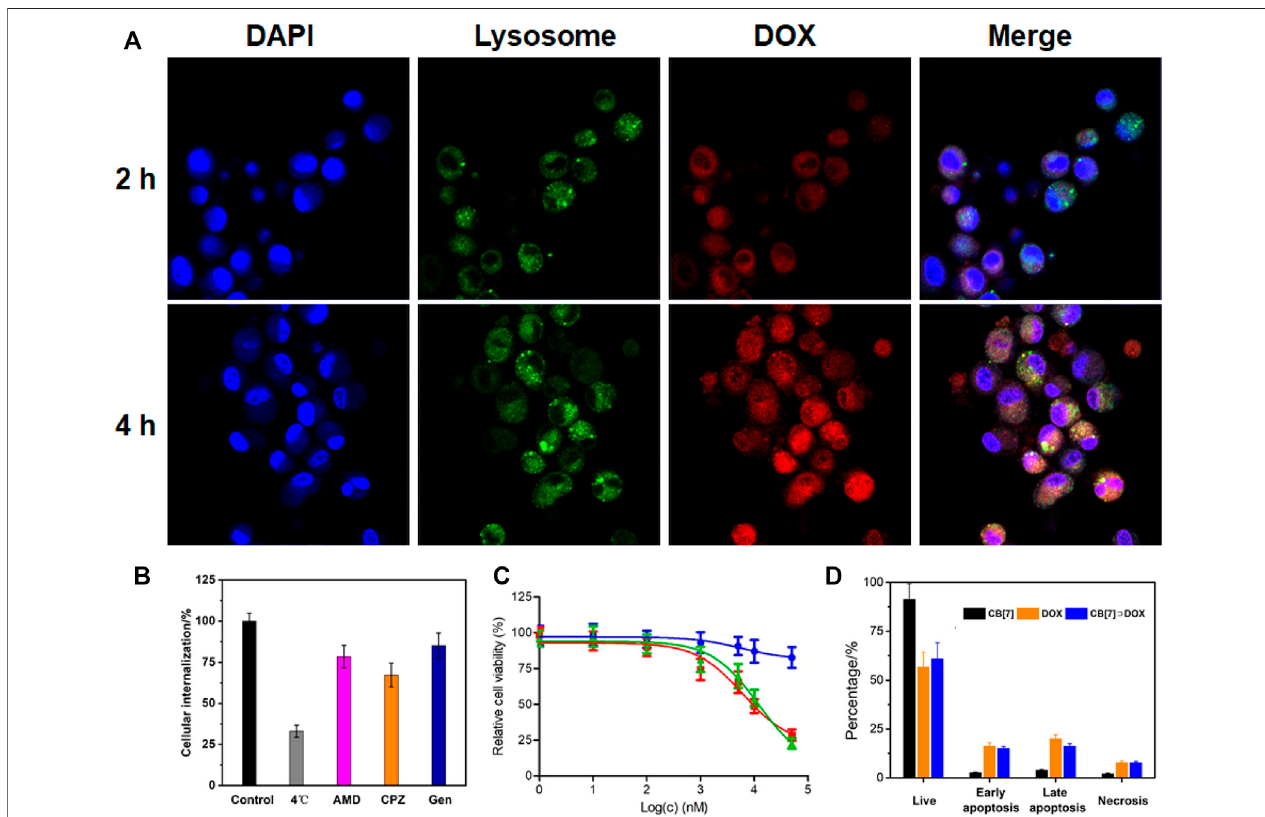
FIGURE 3 | (A) CLSM images of HeLa cells incubated with CB[7] ⊃ DOX for different time periods, (B) internalization ef fi ciency analysis of CB[7] ⊃ DOX after incubationwithdifferentendocytosis inhibitors, (C) cytotoxicity againstHeLacellsincubated withdifferentconcentrationsofCB[7] ⊃ DOXfor24 h(blue:CB[7];red:DOX; green: CB[7] ⊃ DOX), and (D) fl ow cytometric analysis of Annexin-V/PI dual-staining of HeLa cells after different treatments.